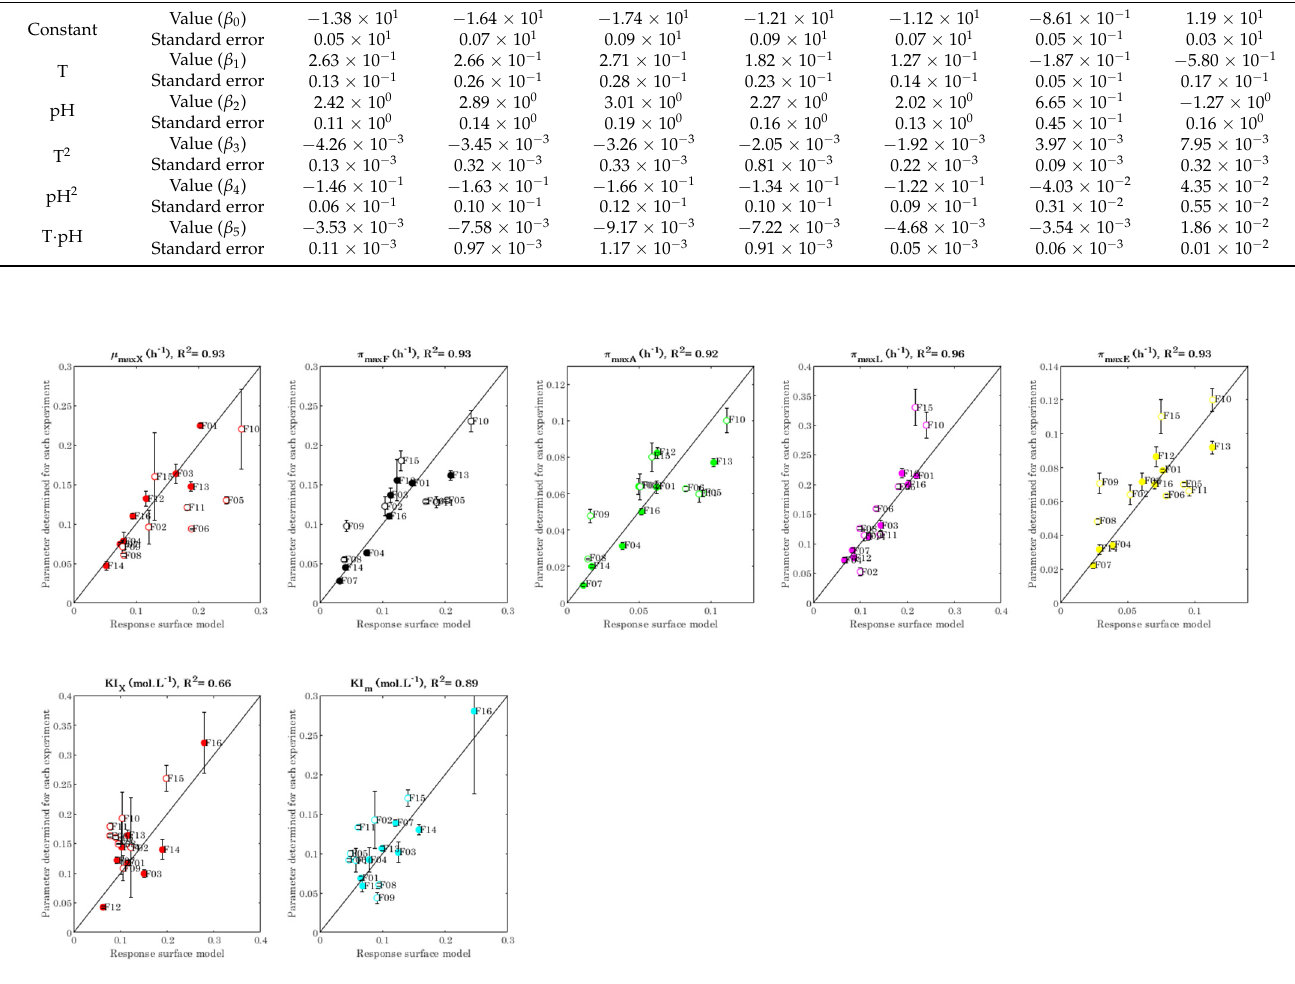
Figure A1. Comparison between model parameters determined for each experiment (Table 2) and parameters computed with the response surface models (Equation (17) using coefficients in Table A2).